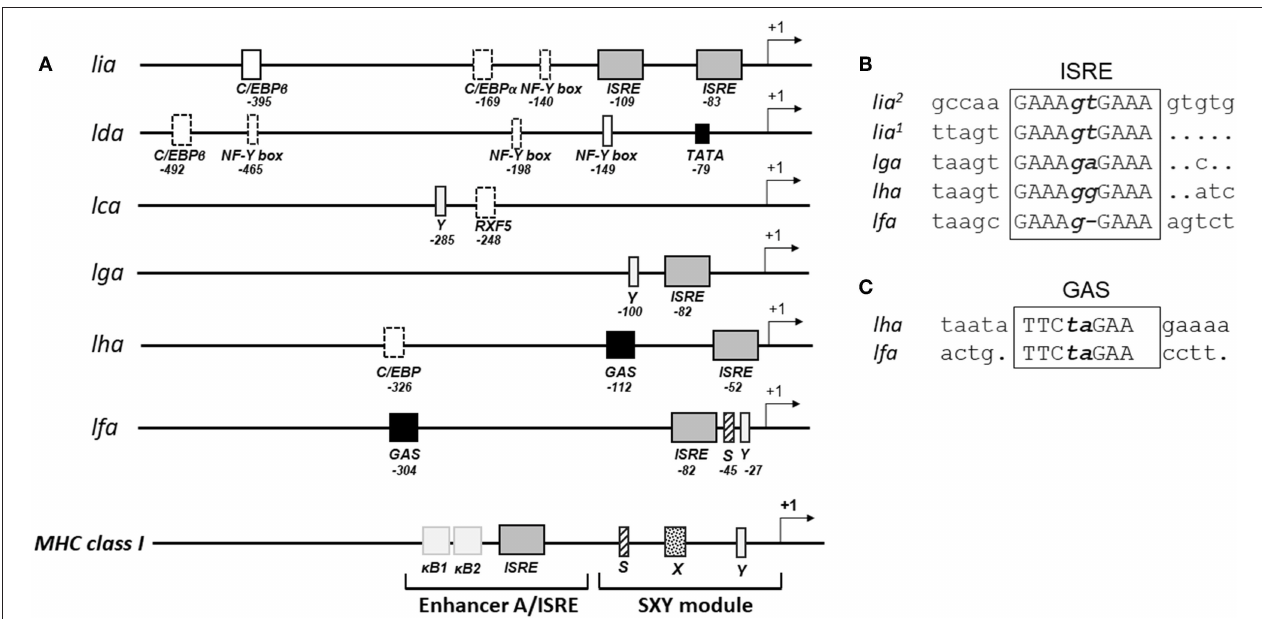
FIGURE 1 | Distinct combinations of response elements in the promoter regions of different L lineage genes. (A) Schematic representation of the putative promoter regions for MHC class I L lineage genes. Five hundred nucleotides upstream of each L lineage gene were identified using SalmonBase and potential regulatory elements were identified via MatInspector (0.75 matrix/identity cutoff) and manual analysis. Regulatory elements are indicated as boxes, with solid lines representing complete conservation with the respective consensus sequences and dotted lines representing a partially conserved promoter element. Arrows indicate transcriptional initiation sites, interferon stimulated response elements (ISRE) are shown as gray boxes and gamma interferon activation sites (GAS) are shown as black boxes. A model illustrating the prototypical MHC class I promoter elements common to many vertebrate species is shown at the bottom. (B) Alignment of the different MHC class I L lineage ISRE motifs [consensus GAAA(N 1 − 2 )GAAA] and (C) GAS motifs [consensus TTC(N 2 − 4